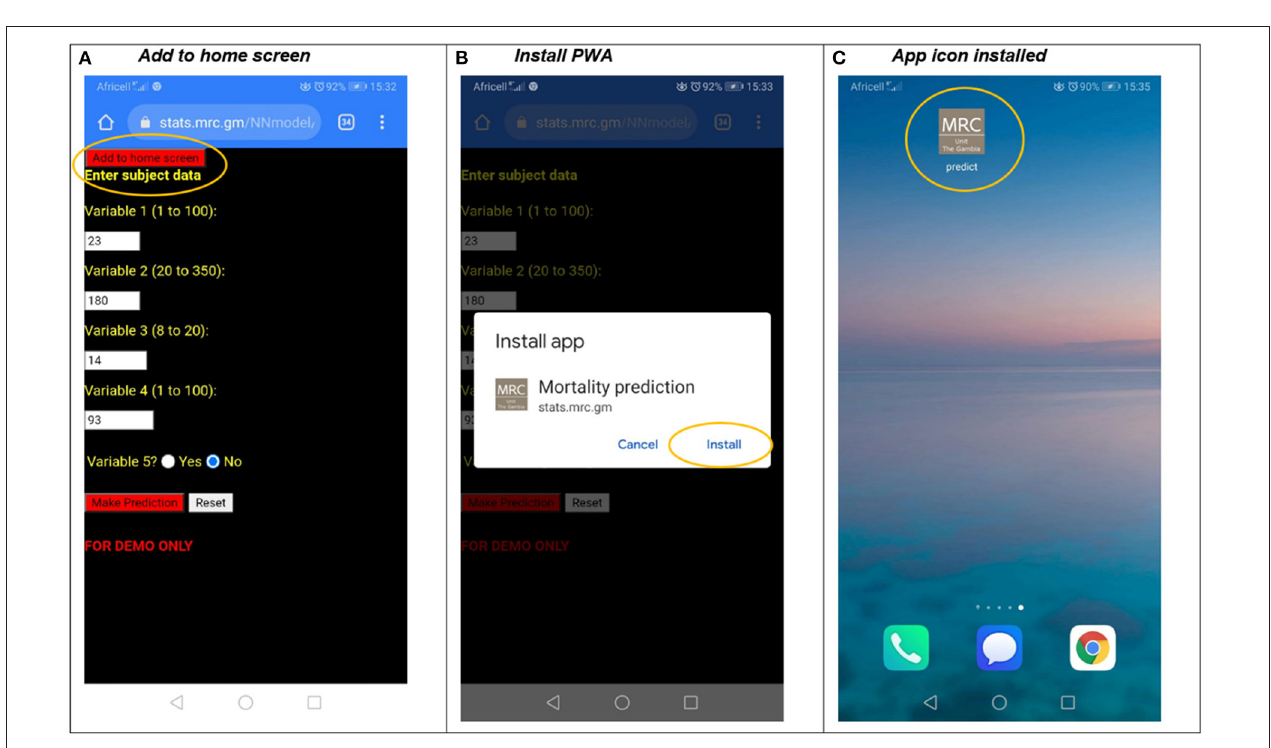
FIGURE 2 | Installing a PWA application on an android